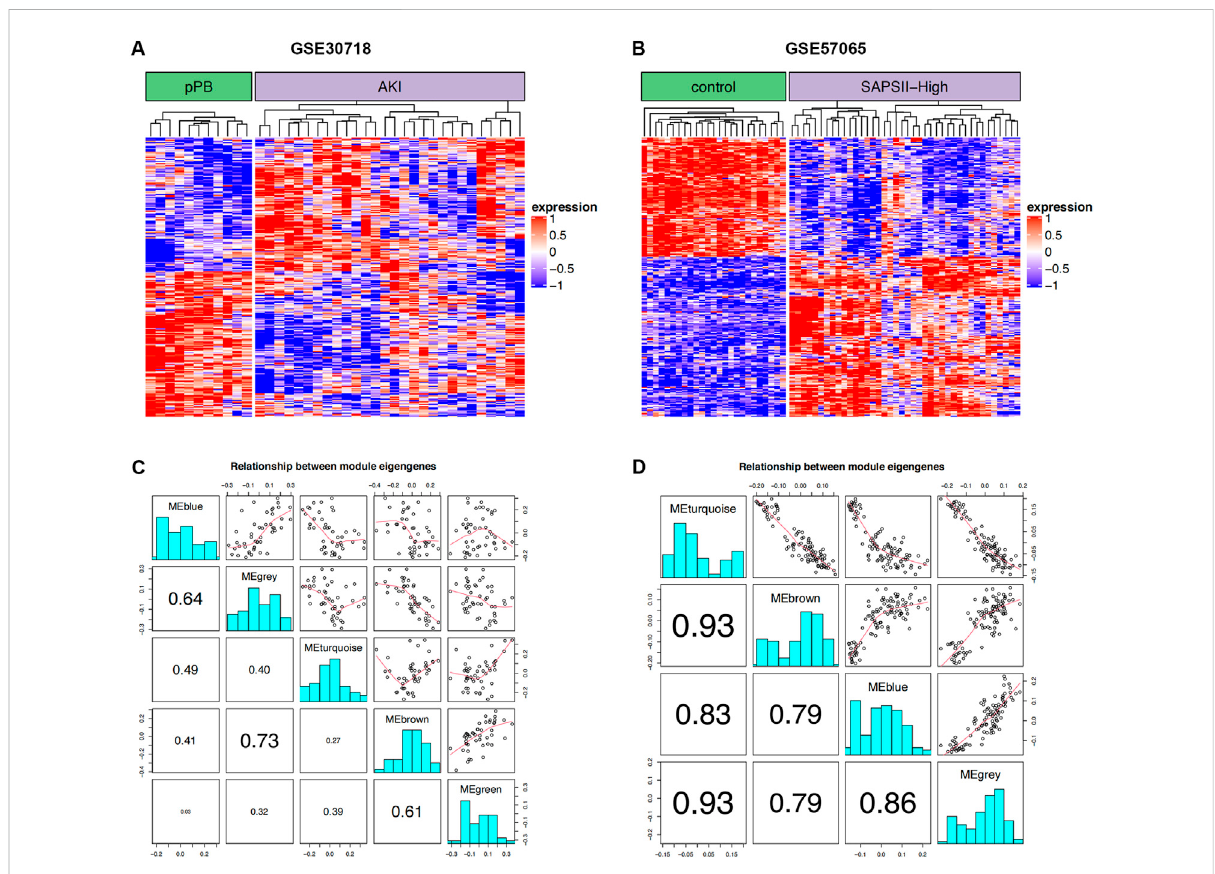
FIGURE 2 WGCNA. (A) Clustering of DEGs in two groups of GSE30718; red and blue represent high and low expression, respectively. (B) Clustering of DEGs in two groups of GSE57065; red and blue represent high and low expression, respectively. (C) Correlation for WGCNA modules in GSE30718. (D) Correlation for WGCNA modules in